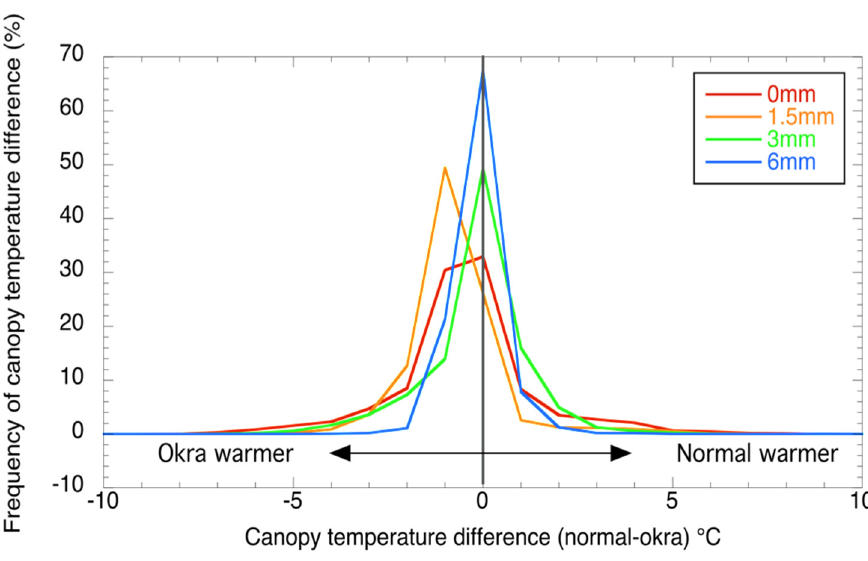
Figure 8. Frequency distribution (%) of the difference in canopy temperature for okra and normal varieties (normal–okra) for four irrigation leaf varieties (normal–okra) for four irrigation treatments.